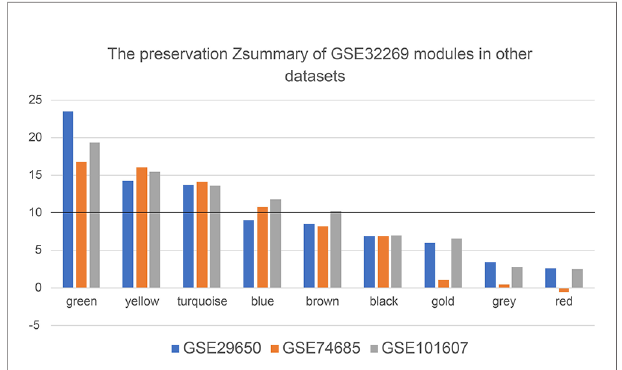
FIGURE 4 | The preservation Zsummary values of eight GSE32269 modules in other datasets (GSE29650, GSE74685 and GSE101607). The black horizontal line is the threshold to de fi ne the highly preserved modules among the four